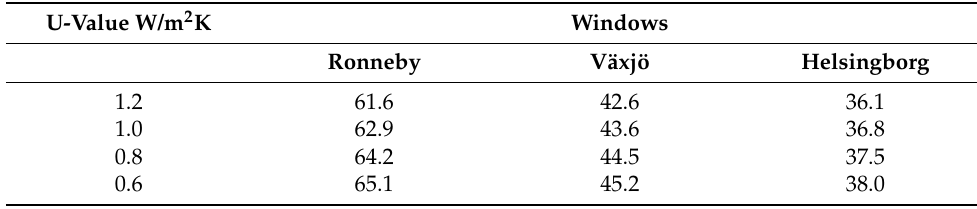
Table 12. Primary energy savings (kWh/m 2 /year) of new windows under different scales of district heating